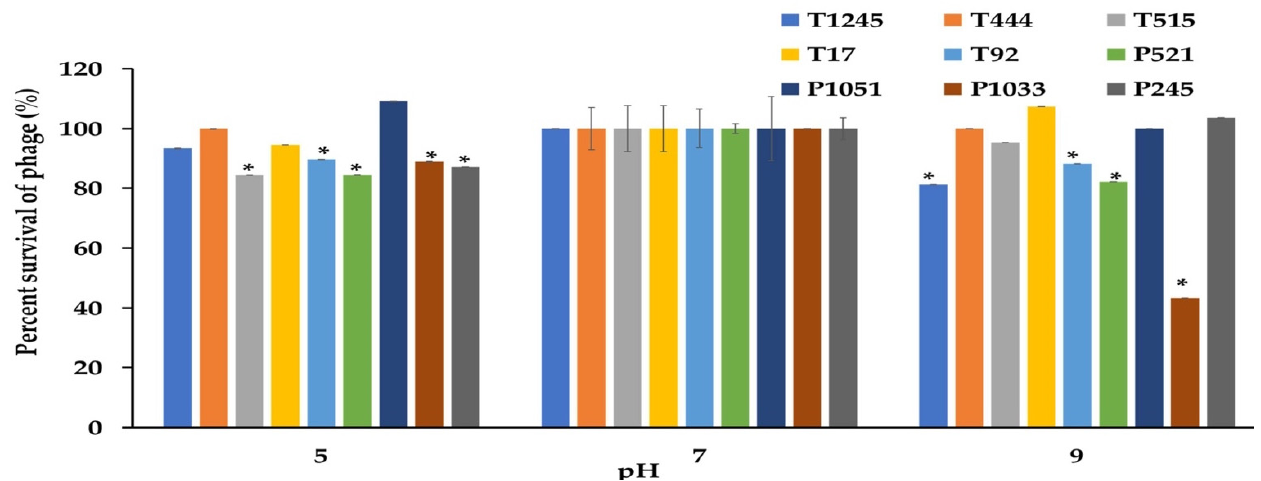
Figure 6. The stability of nine phages at various pHs was measured for 2 h. The results were calcu- lated as the percentage of surviving phage. Three independent experiments were performed in trip- licate, and error bars represent the standard deviations (*, p < 0.05).